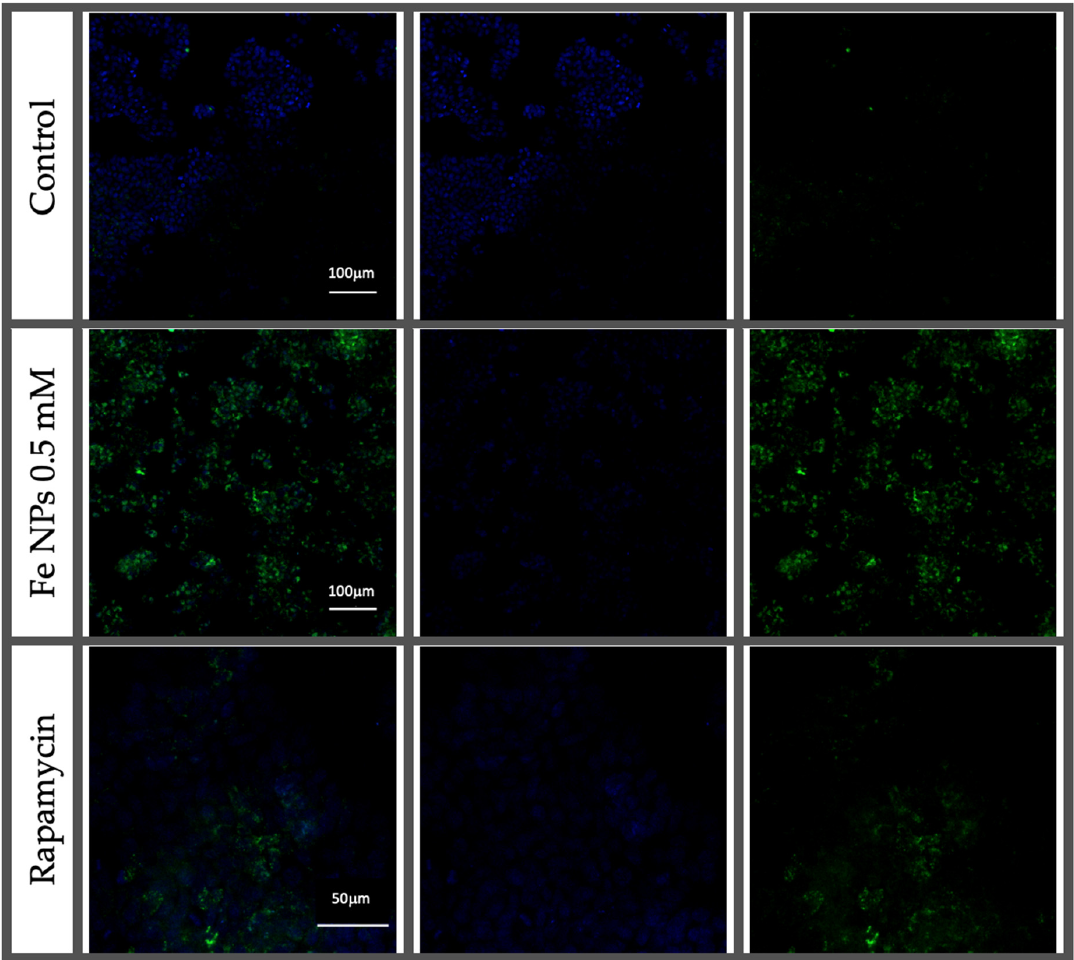
Figure 8. Confocal microscopy images of HT-29 cells exposed to Fe NPs 0.5 mmol L − 1 , rapamycin 0.5 µmol L − 1 and control cells (untreated).